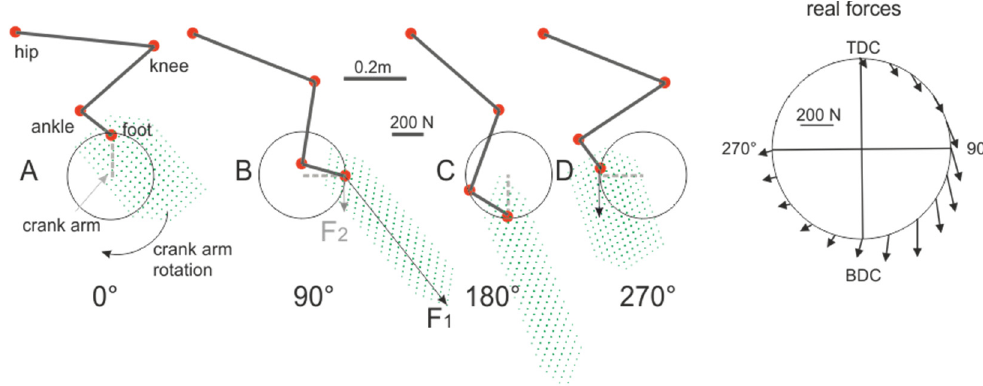
Figure 1. Set of feasible forces at different joint configurations. The figure represents different configurations of the lower limb during the cycle, that is, at 0°, 90°, 180° and 270° of the crank arm angle, respectively. The dotted areas represent the feasible static force vectors at the foot level, given the joint configurations and the maximal torque of each joint. Two examples of feasible force vectors (F 1 and F 2 ) are drawn in (B). F 2 is purely orthogonal to the crank arm (ME = 1), whereas F1 is directed more forwardly (ME < 1). However, F 1 will provide a greater orthogonal component than F 2 , showing that maximizing effectiveness is not necessarily the best option to maximize performance. At 270°, a negative e ff ective force is illustrated (ME < 0). The details of the method used to define the feasible force vector sets can be found in Valero-Cuevas [32] and Kutch and Valero-Cuevas [31]; see text also. On the right, illustration of real forces vectors. BDC: bottom dead center; ME: mechanical e ff ectiveness; TDC: Top Dead